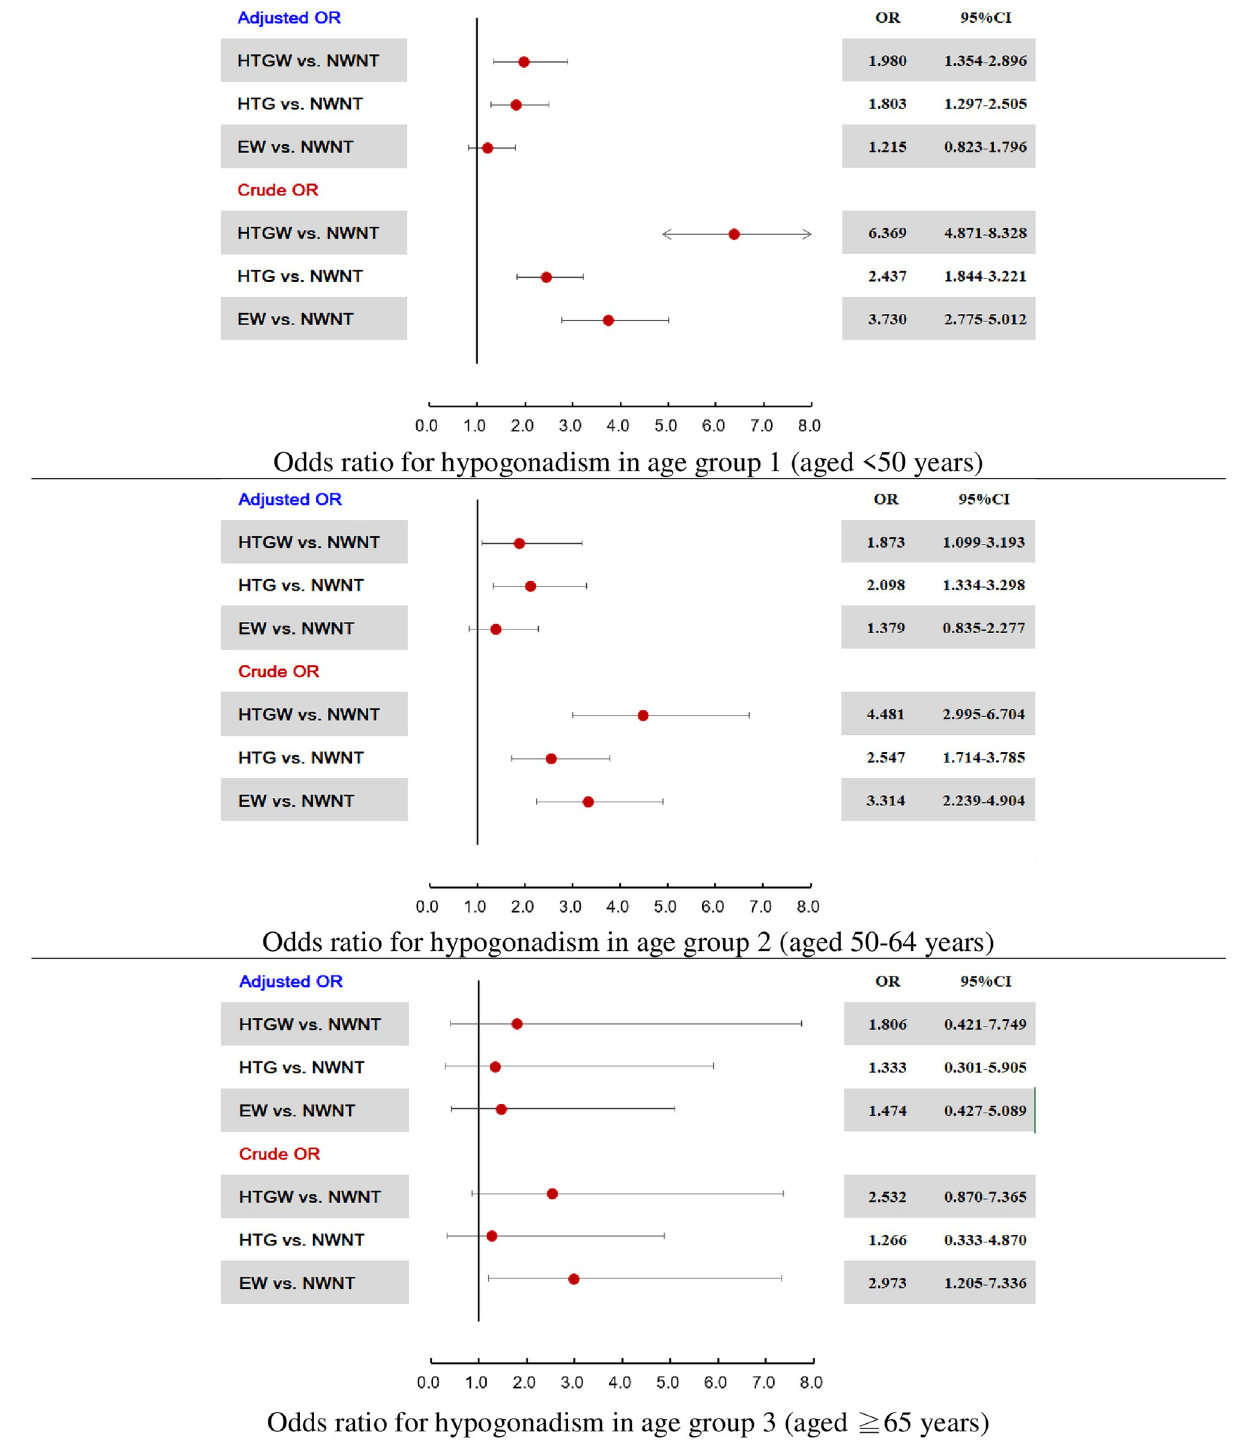
Fig 2. Odds ratio for hypogonadism stratified by age group. Adjusted OR were adjusted for body mass index, fasting blood glucose levels, cholesterol levels, high-density lipoprotein levels, low-density lipoprotein levels, and smoking status.